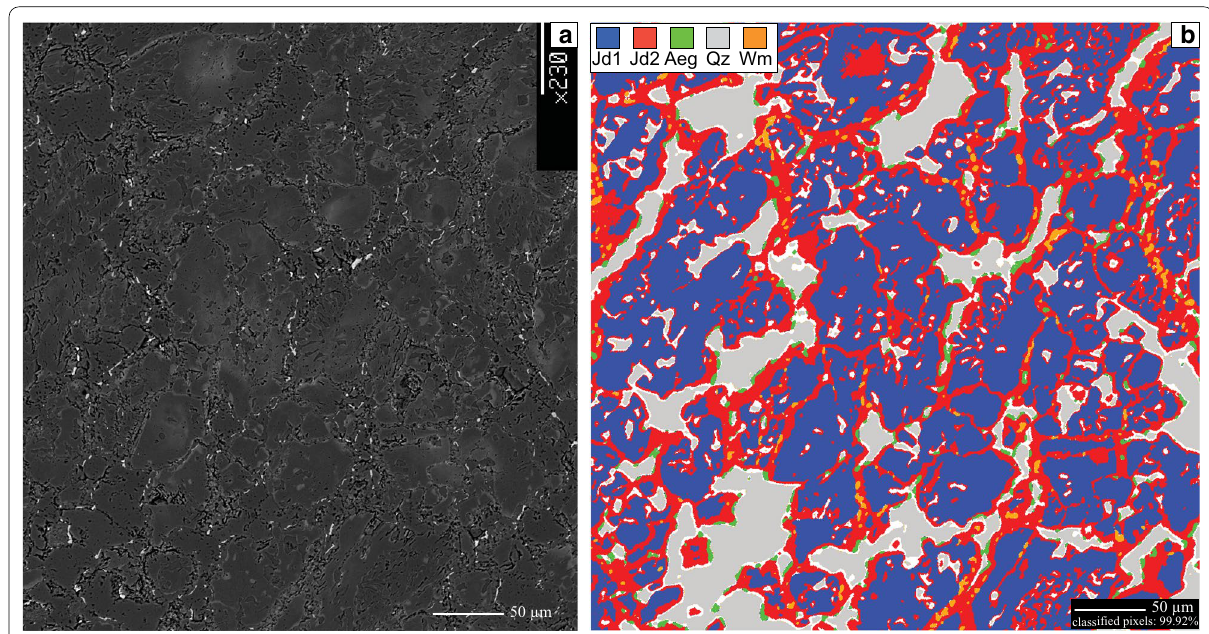
Fig. 10 Results of Q-XRMA second cycle for Cpx aggregates of garnet-free gneiss (CR115-C3 microdomain). a Back-Scattered Electron (BSE) image of Fig. 5h, rotated of 90 degree. b Cpx generations classification and mineral classification of X-ray map. Jd2 occurs as a corona of Jd1 and Aeg forms between Jd grain boundaries. The amount of pixels classified is